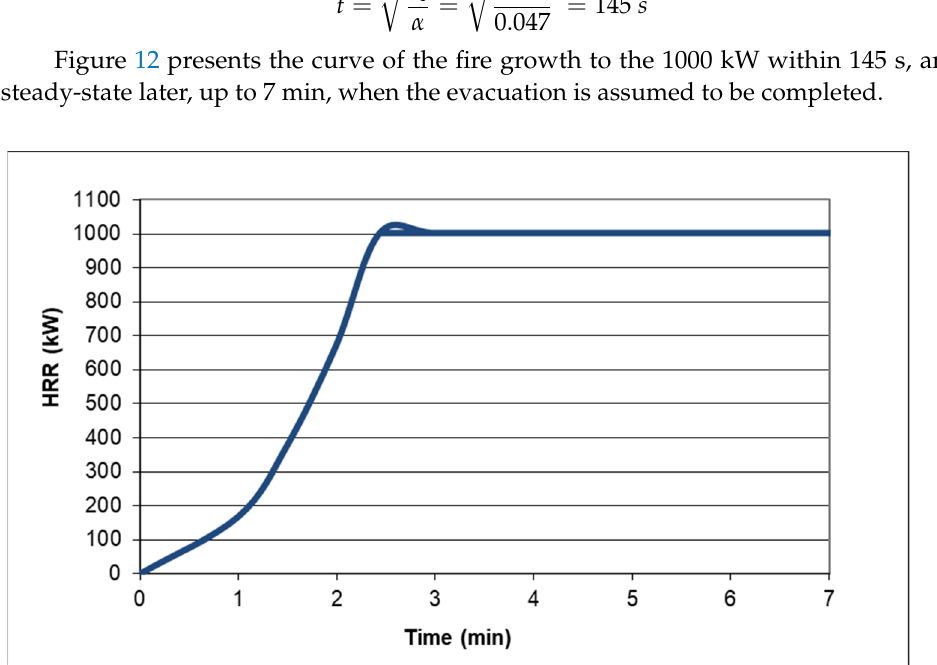
Figure 12. The fire growth curve.